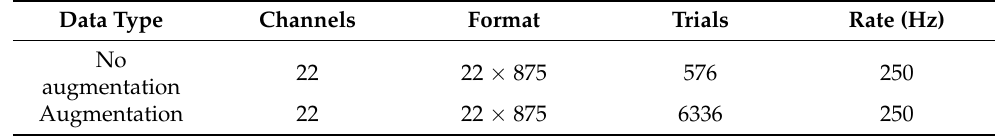
Figure 6. The timing scheme schedule of each MI trial in the BCI competition IV 2a dataset. Table 2. The details of the experimental